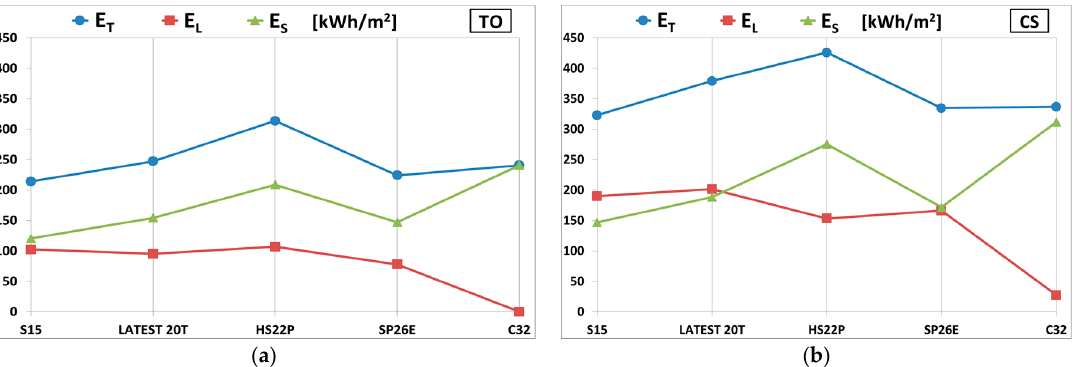
Figure 8. Yearly sensible E S , latent E L and total E T energy stored for the different PCMs. Values for Turin are on the left ( a ) and for Cosenza are on the right ( b ).